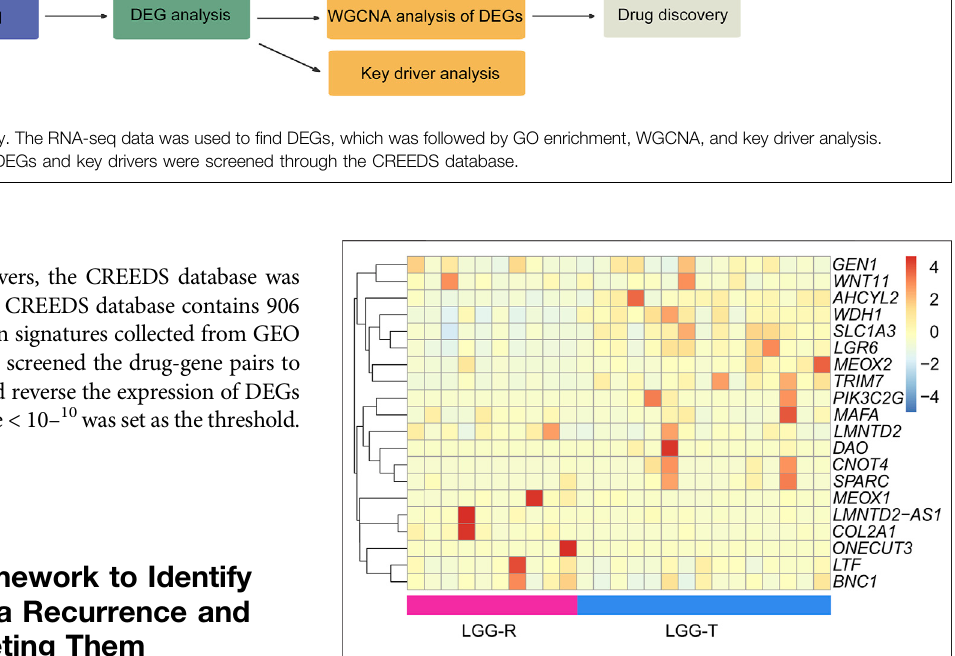
FIGURE 2 | The heat map of the DEGs between LGG-P and LGG-R samples. Dao, mdh1, slc1a3, CNOT4, meox2, pik3c2g, LGR6, ahcyl2, SPARC and LTF were the top 10 differentially upregulated genes; LMNTD2- AS1, MAFA, COL2A1, ONECUT3, MEOX1, BNC1, LMNTD2, GEN1, Wnt11 and trim7 were the top 10 differentially down regulated